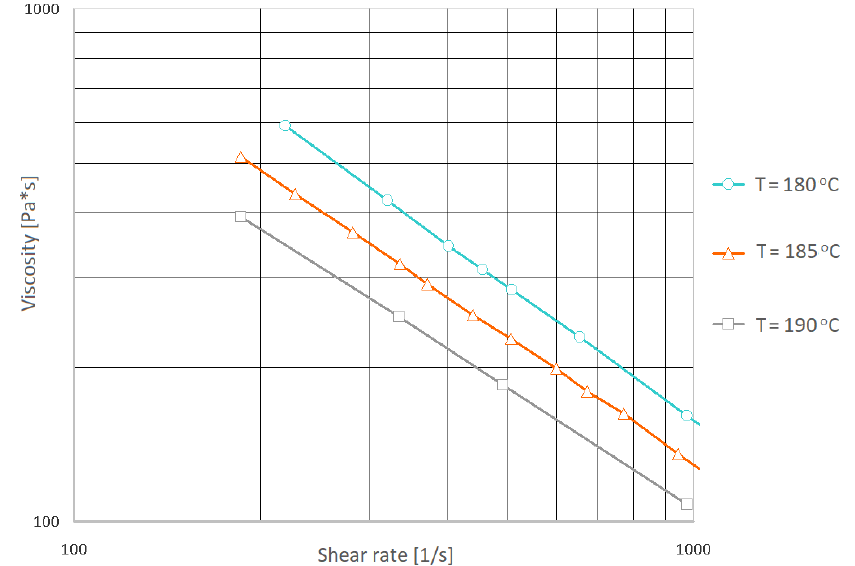
Figure 1. Viscosity curves for the K30 biocomposite determined in real conditions (in the injection mold). Table 1. The Cross-WLF parameters of the K30 biocomposite model.